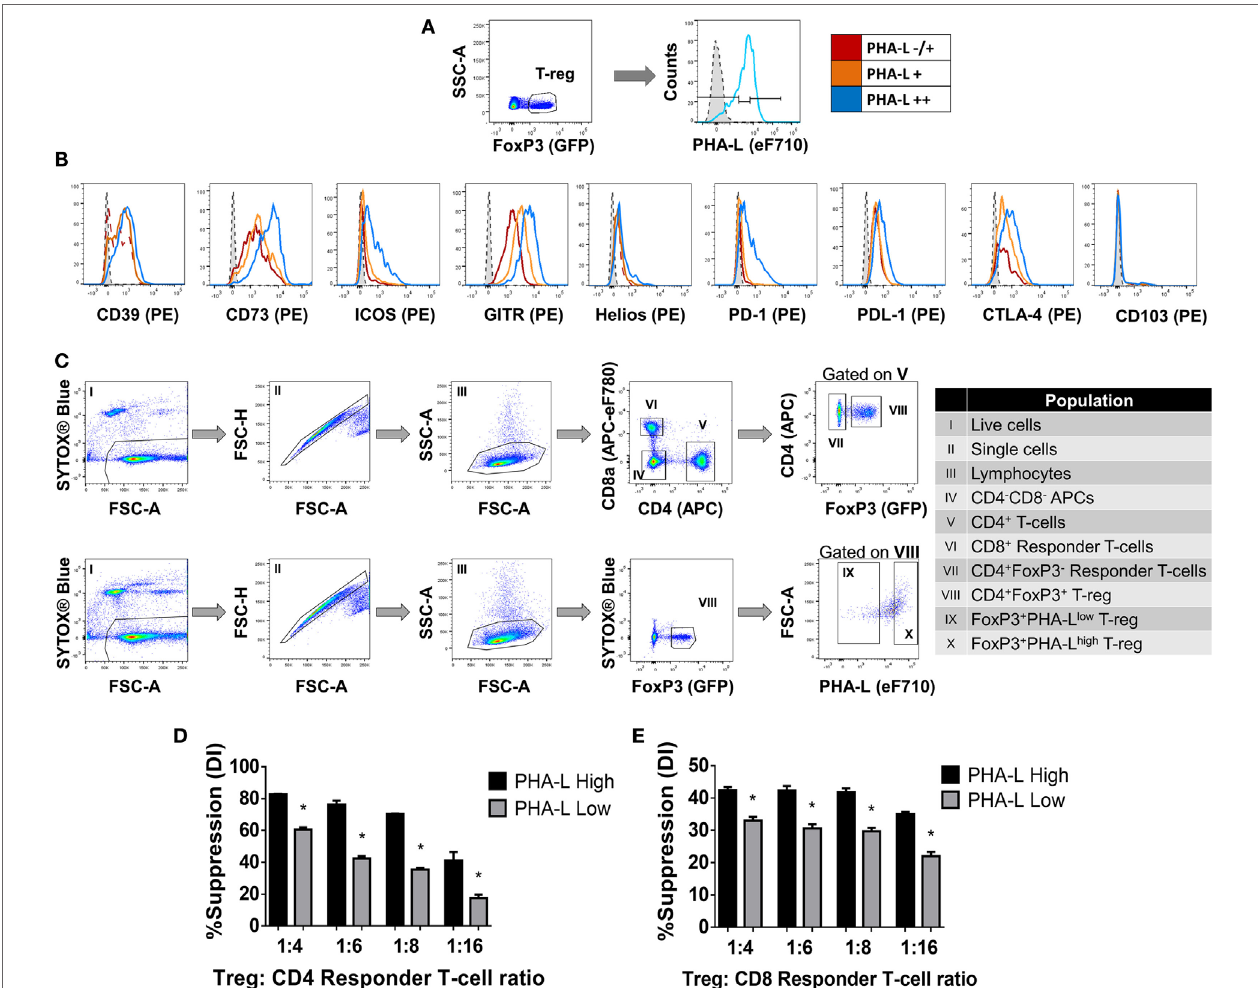
FigUre 3 | Complex tri/tetra-antennary N -glycan surface expression correlates with expression levels of Treg markers and suppressive potency. (a,B) The expression of CD39, CD73, ICOS, GITR, Helios, PD-1, PDL-1, CTLA-4, and CD103 was evaluated in Treg subpopulations within freshly isolated spleen and lymph node cells from C57BL/6 FoxP3.EGFP mice defined according to Phaseolus vulgaris leucoagglutinin (PHA-L) binding intensities [low ( − / + ), mid ( + ) or high ( ++ )]. Dashed tinted histograms represent the median fluorescence intensities for the eF710 and PE fluorescence minus one (FMO) controls for lectin and antibody labeling, respectively ( n = 3 individual animals). (c) Gating strategy for FACS purification of cell populations used in the functional assay (D,e) . (D) CD4 + and (e) CD8 + responder T-cells were labeled with CellTrace ™ Violet and cocultured in the presence of CD4 − CD8 − antigen-presenting cells and purified PHA-L high or PHA-L low Treg at Treg: responder T-cell ratios of 0:1, 1:4, 1:6, 1:8, and 1:16 for 4 days with anti-CD3 stimulation. Suppressive function was quantified for PHA-L high and PHA-L low Treg based on responder T-cell division index (DI) and presented as the calculated percent suppression [%Suppression (DI) = 100 − [(DI of the 1: X )/(DI of 0:1)] × 100 in which 1: X represent cocultures with Treg and 0:1 refers to cocultures with responder T-cell alone]. Data represent mean ± SD ( n = 3 technical replicates). Results for proliferative assays were confirmed in a repeat experiment. Statistical analysis was performed by permutation test with an unpaired design (* p value ≤